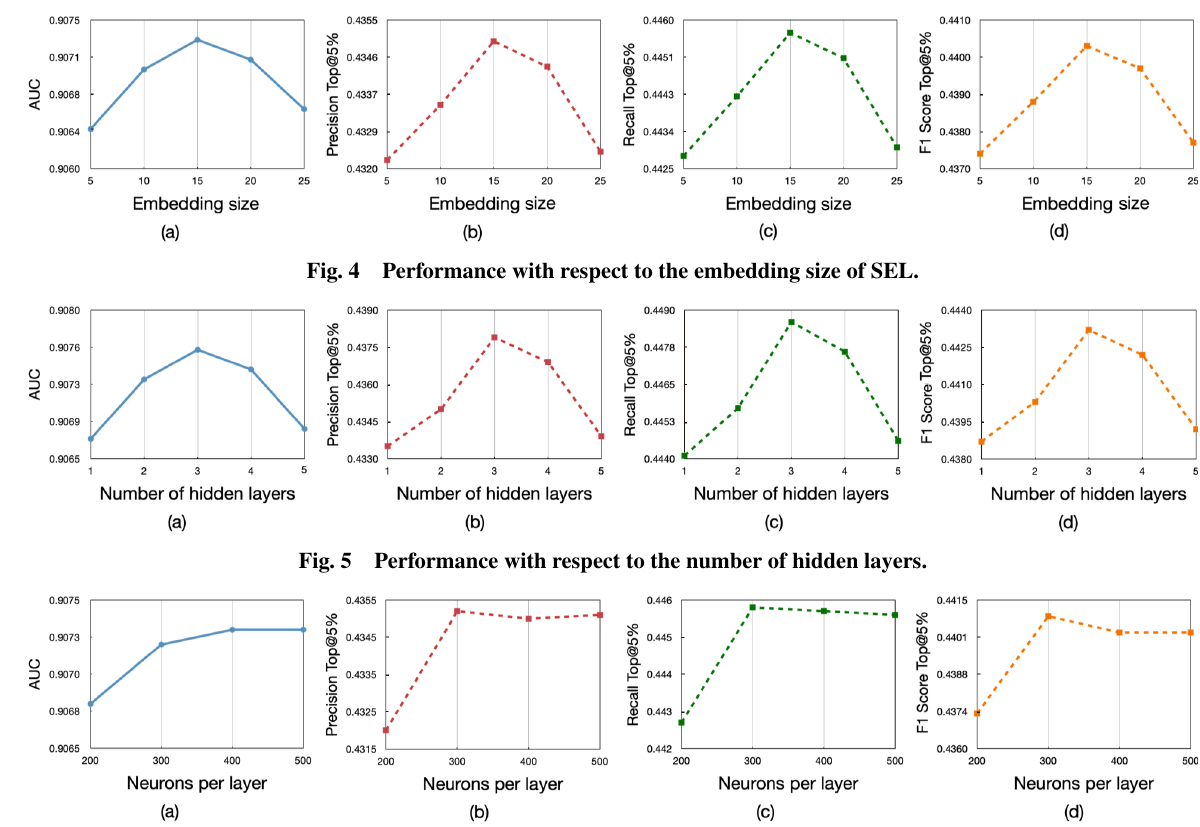
Fig. 6 Performance with respect to the number of neurons per